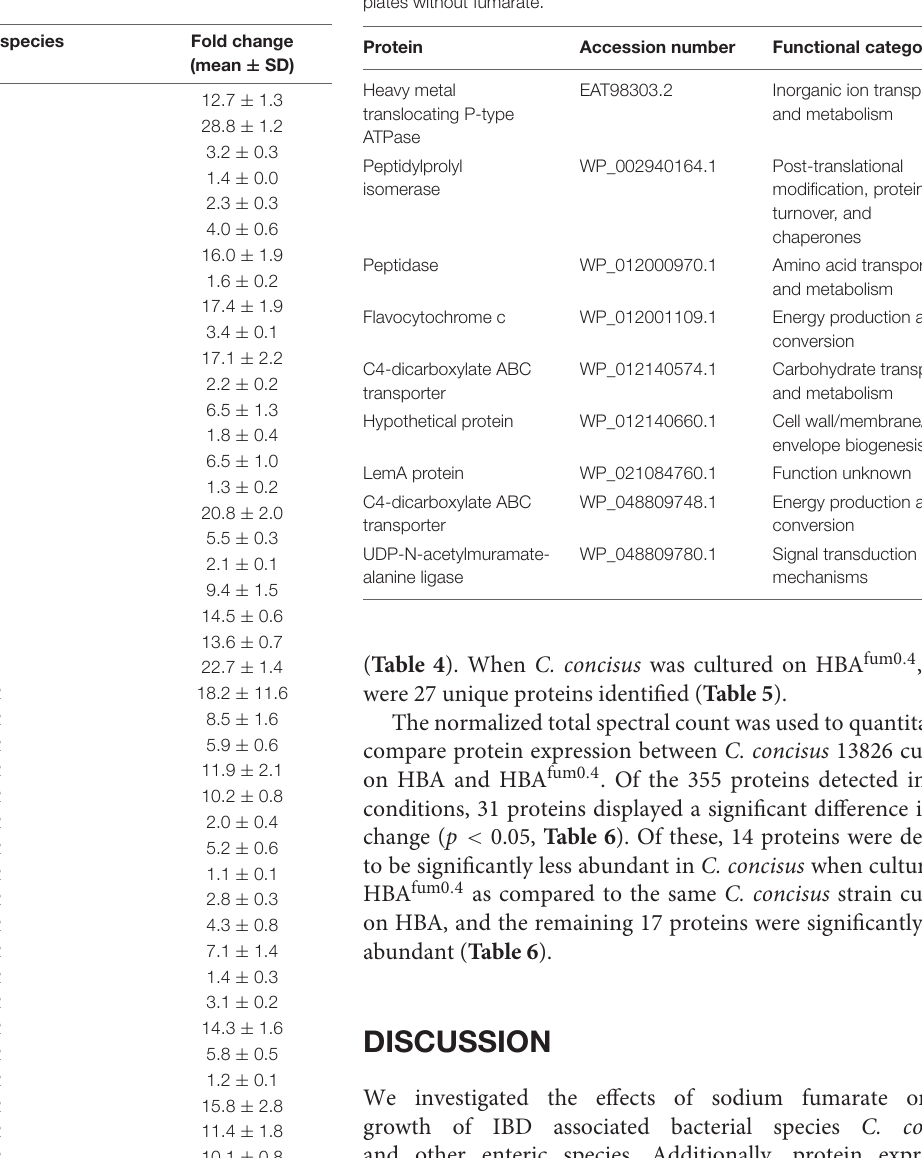
TABLE 4 | Proteins only identified in C. concisus 13826 when cultured on HBA plates without fumarate. Protein